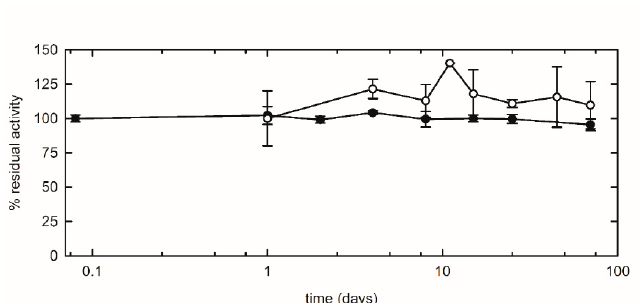
Figure 8. Comparison between free (closed circles) and encapsulated (open circles) puuE catalytic activity over storage time. Reactions were carried out at 37 °C in 20 mM potassium phosphate, pH 7.4, in the presence of 0.2 mM racemic allantoin, and stopped after a fixed time of 10 min. The mean value of three reactions at day 0 (free puuE) and day 1 (encapsulated puuE) represent the reference for the normalization of subsequent time points. The activity of immobilized puuE was recorded from day 1 because of the time required for silica gel matrix aging, and for each time point a new aliquot of puuE encapsulated on day 0 was used. Data are represented as mean ± s.d. of three replicates and lines are for eye-guidance only.